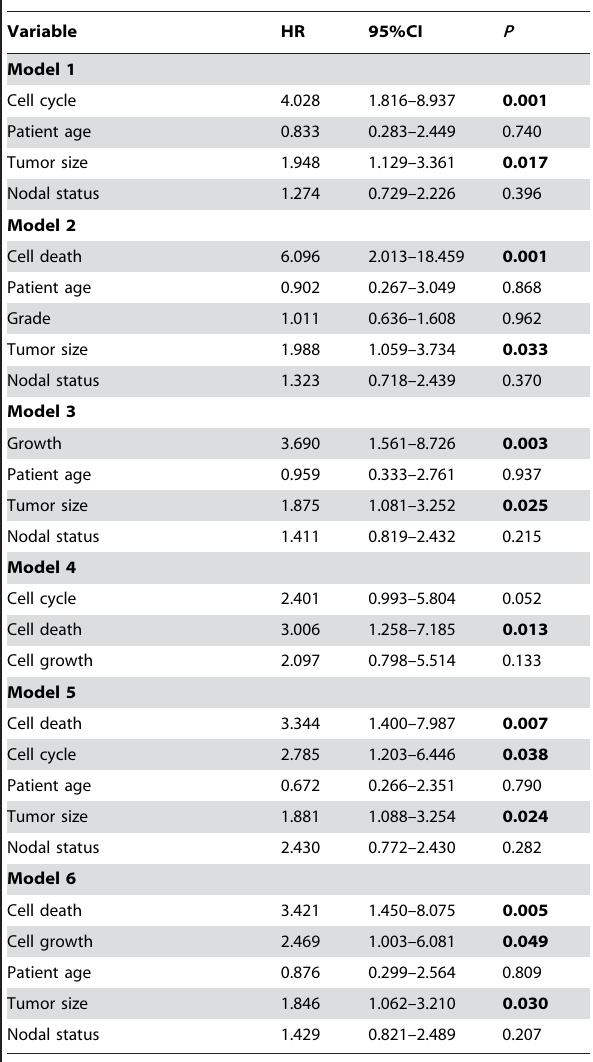
Table 3. Cox regression